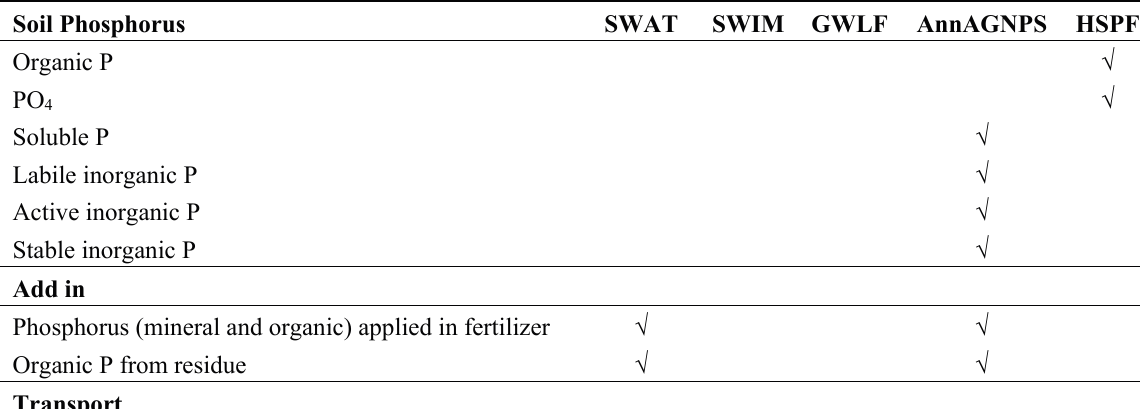
Table 6. Phosphorus